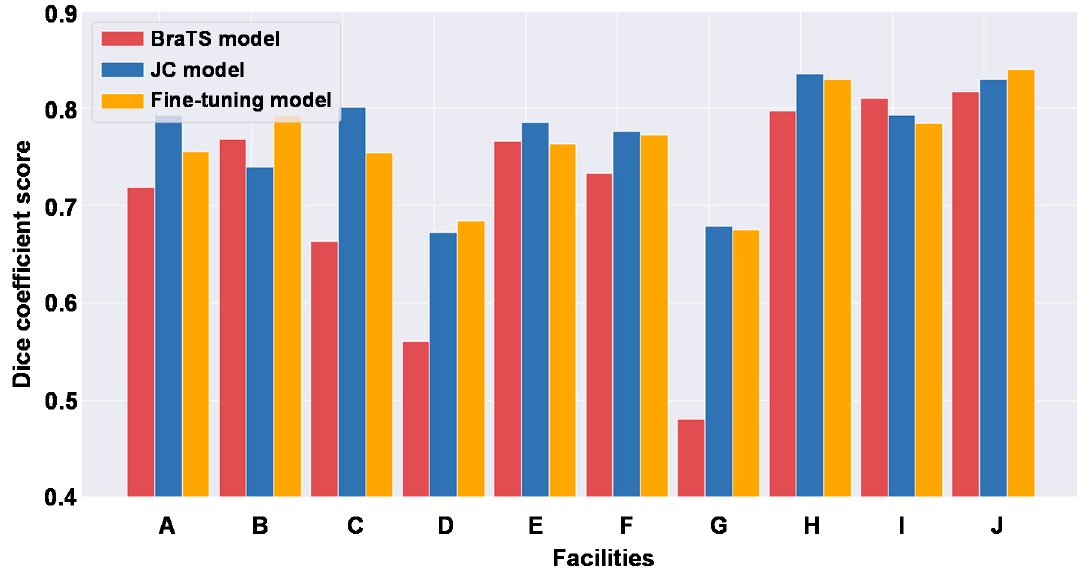
Figure 2. The results of three types of machine learning models for segmentation. A bar graph shows the Dice coefficient score for each facility. The horizontal axis is the facility, the vertical axis is the Dice coefficient score, and the colors indicate the types of machine learning models for segmentation. The Dice coefficient score of the fine-tuning model was significantly improved compared to that of the BraTS model and was comparable to that of the JC